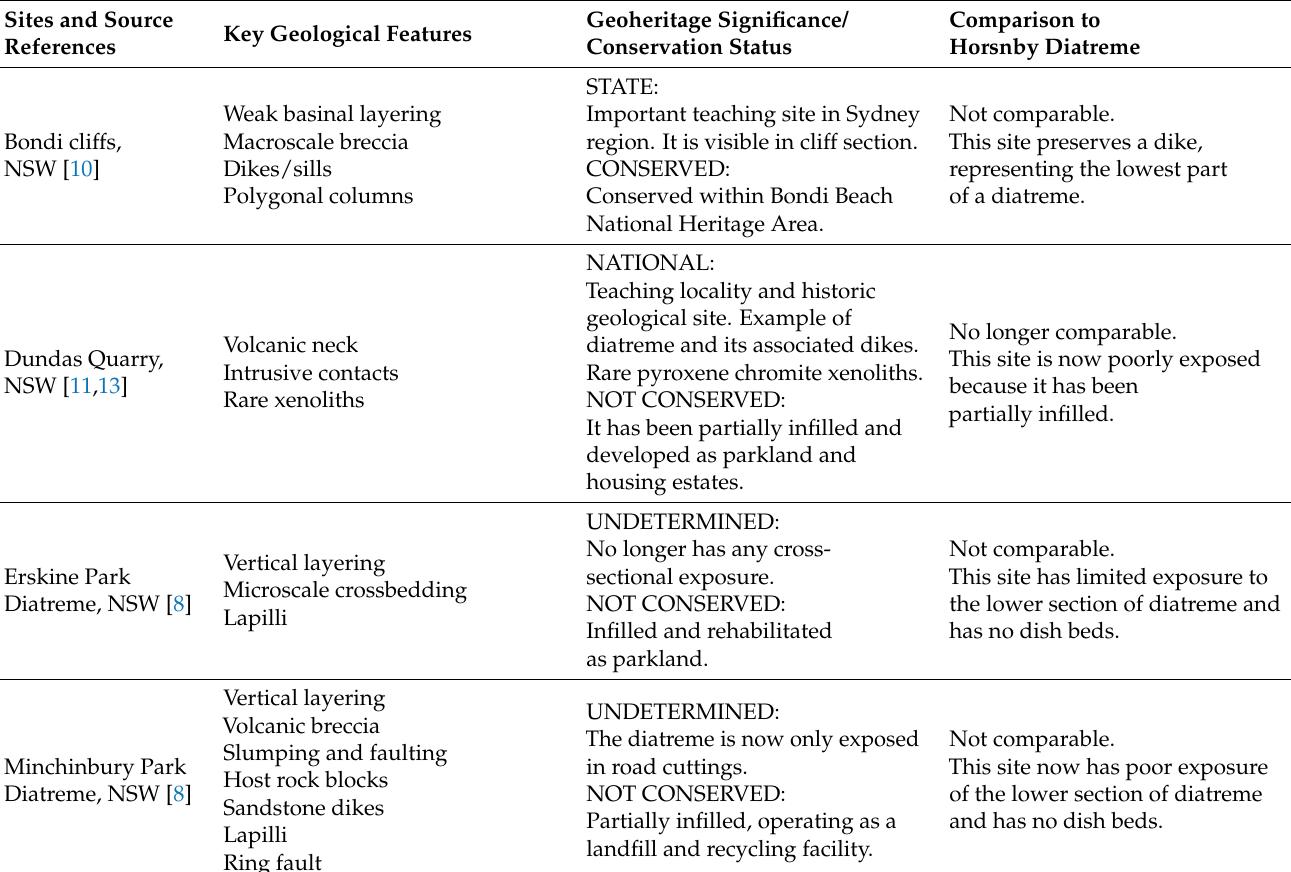
Table 4. Relationship of Hornsby Diatreme with selected other diatremes in NSW and worldwide based on a literature